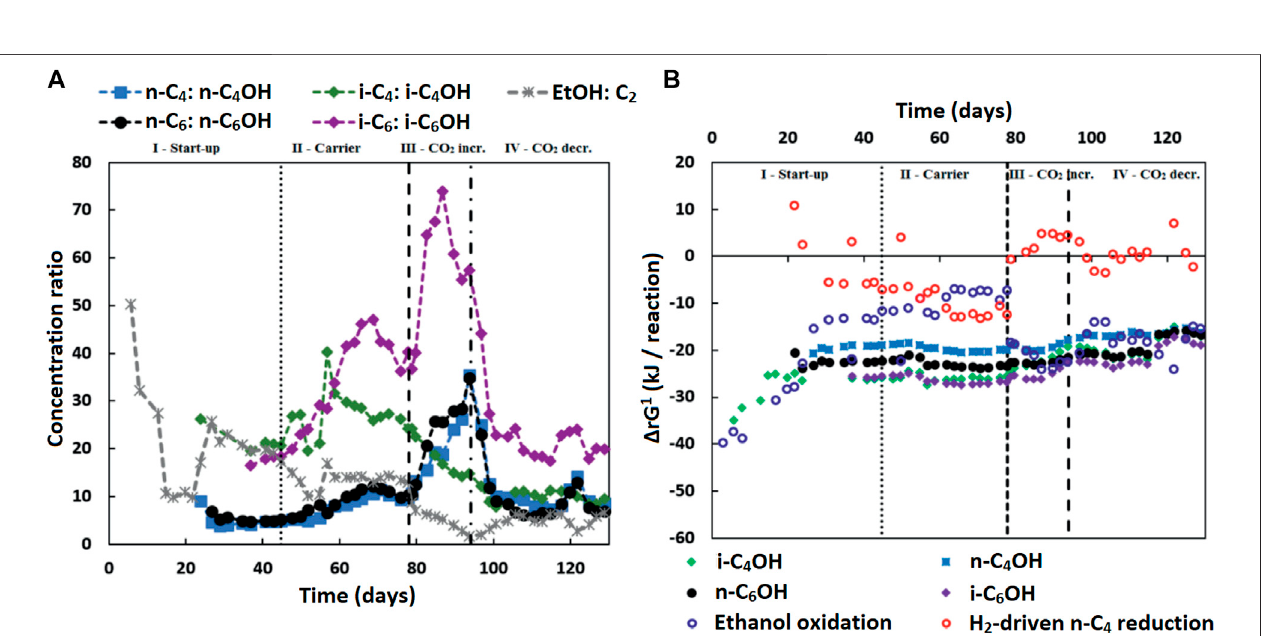
FIGURE4|(A) Theconcentrationratiosofcarboxylatestocorrespondingalcohols(andethanoltoacetate)areshown.Theseratiosseemtobeinverselycorrelated totheethanoltoacetateratio,especiallyinthelaterphases(IIIandIV),exceptforthei-C 4 toi-C 4 OHratio.Isobutyratewascontinuouslyfedintothereactorandpresentat highconcentrationsinthebroth.Thiswouldcontributetothedrivingforceofisobutanolformation,whilelesseningtheinversecorrelationofthei-C 4 toi-C 4 OHratiotothe ethanoltoacetateratio. (B) TheGibbsfreeenergychange( Δ rG 1 )isshownforthereactions: Ethanol + Carboxylate → Acetate + CorrespondingAlcohol (foriC 4 OH, n-C 4 OH, n-C 6 OH and i-C 6 OH), direct ethanol oxidation and hydrogenotrophic butyrate reduction. The Gibbs free energy change was adjusted for the conditions (including pH and hydrogen partial pressure for ethanol oxidation and hydrogenotrophic reduction) in the reactor. The combined hydroxyl-carboxyl exchange reaction seems to remain stable in the range of -15 – 25 kJ reaction per reaction. The used Gibbs formation energies and assumption for the calculations are given in Supplementary Table S6